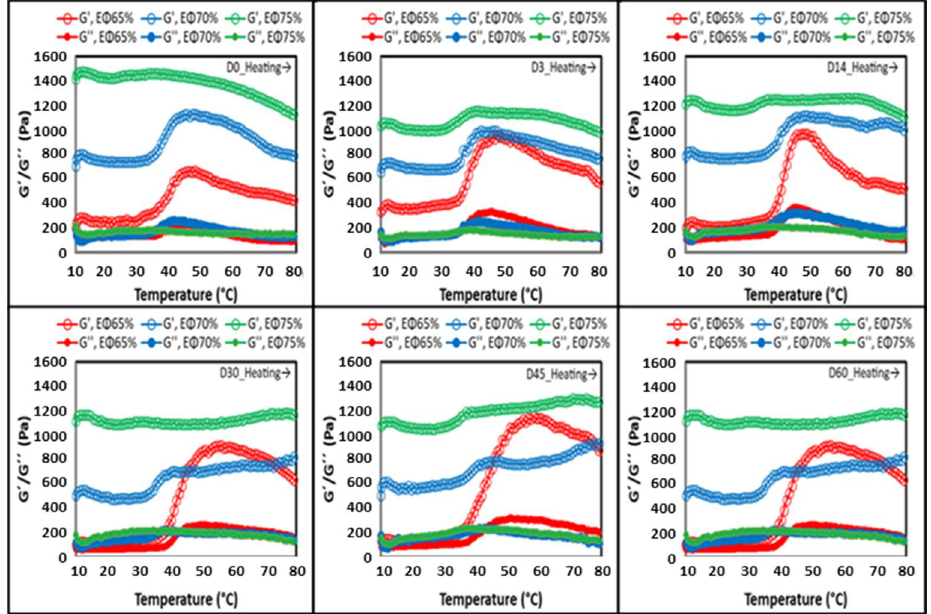
Figure 4. Temperature sweeps (heating) for EΦ65%, EΦ70%, and EΦ75 % throughout 60 days storage at 25 °C.